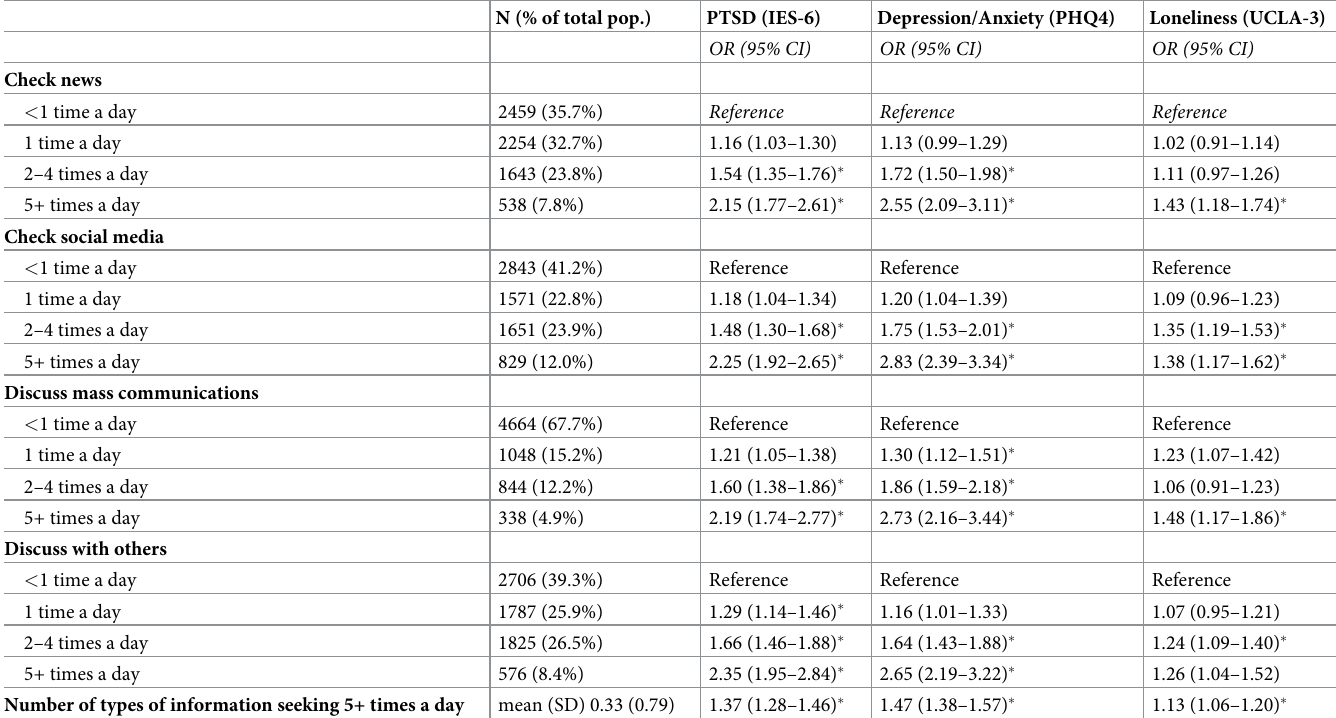
Table 2. Model results for elevated symptoms of PTSD, depression/anxiety, and loneliness in relation to frequency of different types of information seeking a . N (% of total pop.)